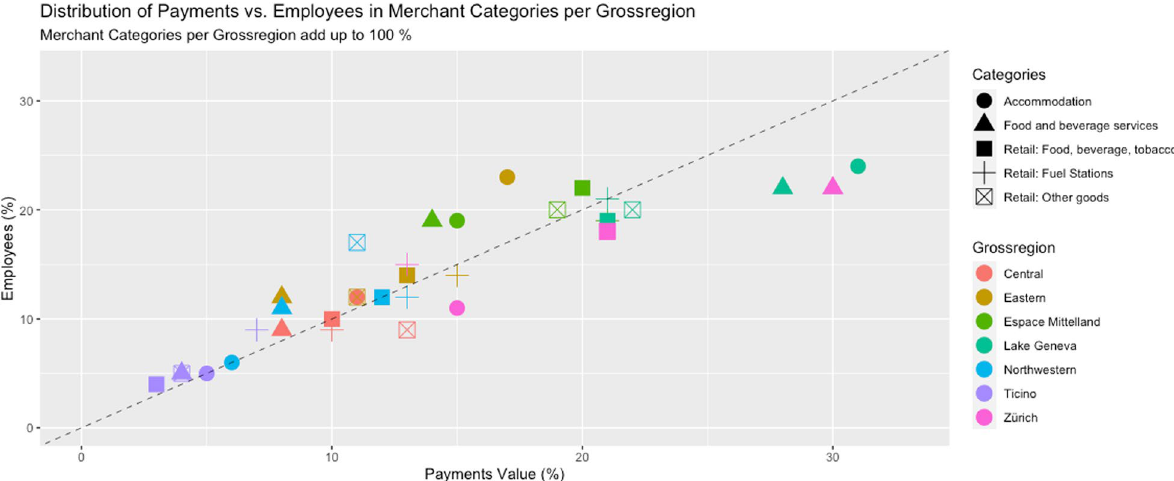
Fig. 7 Distribution of payment turnover vs. employees by merchant category and NUTS-2 region ( Grossregion ). Note : The figure shows a comparison between the geographical distribution of card payment transactions by volume (acquiring data set; the figure plots total spending in 2019) and employees in Switzerland (data as per 2018). The data are displayed following the merchant category * geographic region categorization as given by the Swiss NUTS-2 regions ( Grossregion ), on a percentage basis. On the y-axis, the percentage share of employees working in a specific merchant category of the specific Grossregion are displayed (merchant categories per Grossregion add up to 100%). On the x-axis, the corresponding payment shares are displayed. The colors indicate the respective Swiss Grossregion while shapes indicate merchant categories. The dotted line shows the 45 degree line. Data source: ACQ_POS_Grossregion_NOGA.csv, FSO « Arbeitsstätte und Beschäftigte nach Kanton und Wirtschaftsart » (https:// www. bfs. admin. ch/ bfs/ de/ home/ stati stiken/ indus trie- diens tleis tungen/ unter nehmen- besch aefti gte/ wirts chaft sstru ktur- unter nehmen. asset detail. 23284 723.